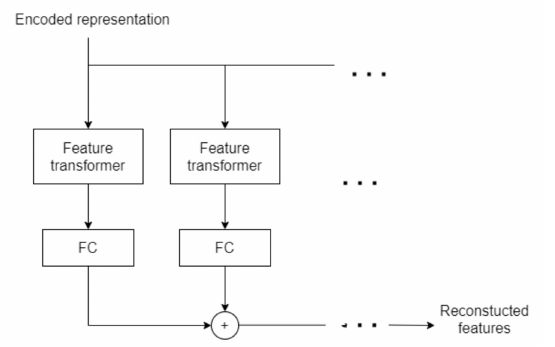
Figure 6. The topological structure of the